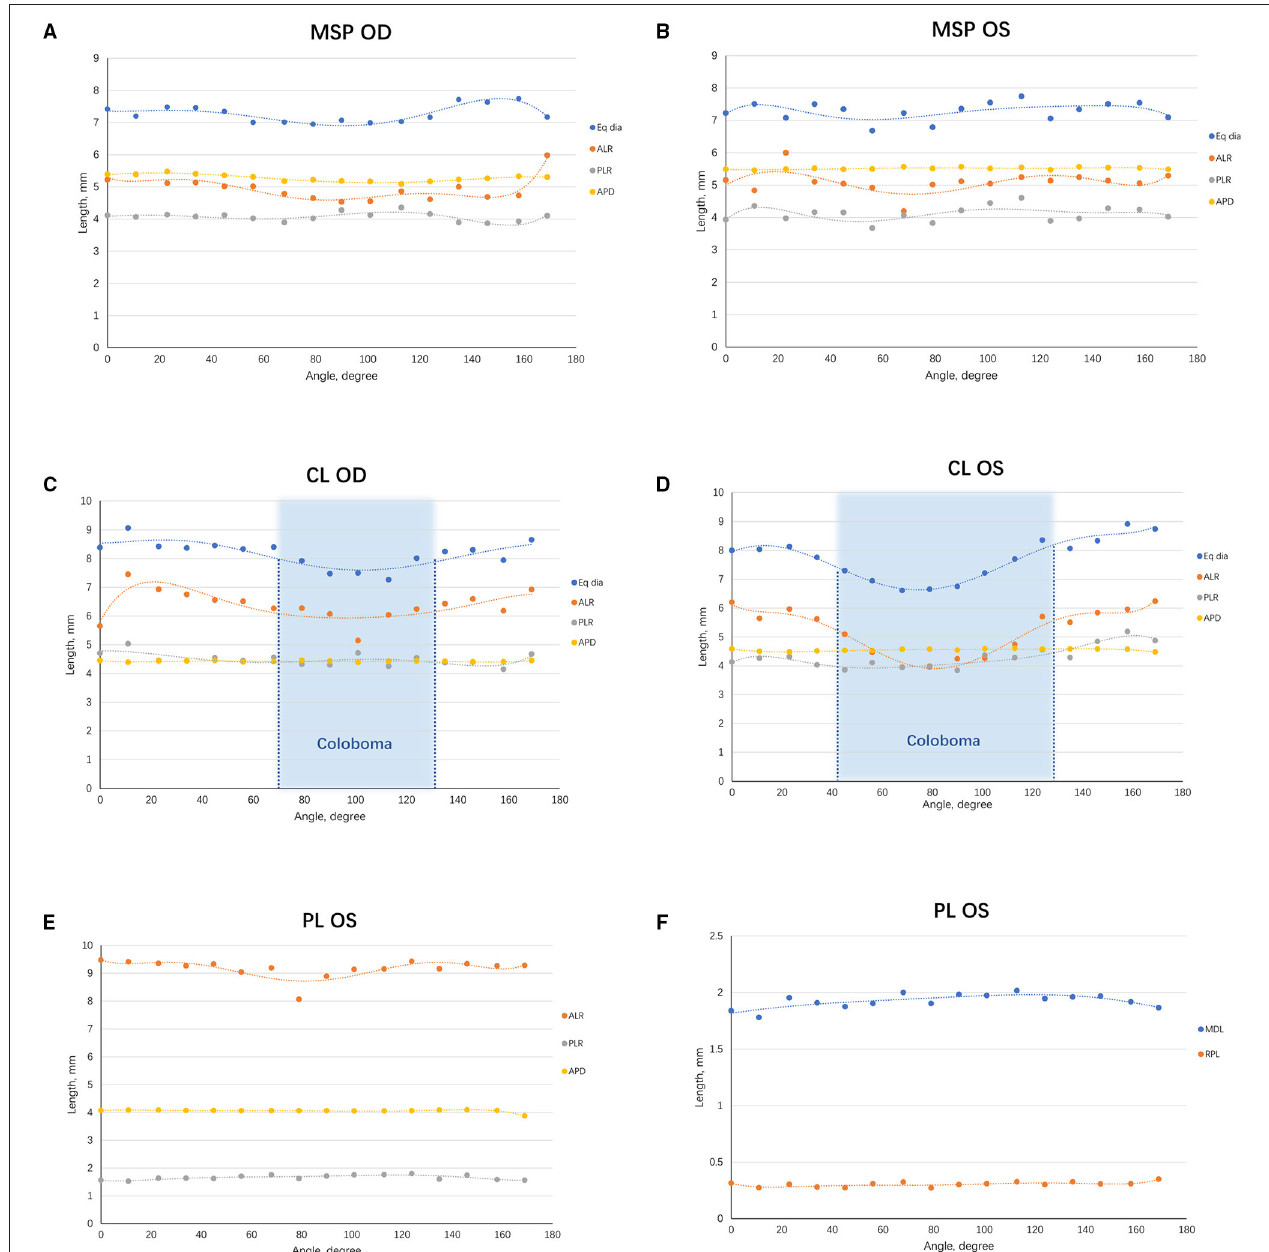
FIGURE 4 | Scatterplots demonstrating the trend of lens biometric parameters from various angles. (A) The lens biometric parameters of the right eye of MSP at different angles were plotted and fitted in curves. (B) A similar graph was made on the left one. (C) The lens biometric parameters of the right eye of CL at different angles were plotted and fitted in curves. The coloboma ranged from 250 ◦ to 311 ◦ (indicated in the blue area). (D) A similar graph was made on the left one. A larger range of coloboma was observed in the left eye (222 ◦ to 308 ◦ , indicated in the blue area). (E) The ALR, PLR, and APD of the eye with PL. (F) The MDL and RPL of the eye with PL. ACD, anterior chamber depth; ALR, anterior lens radius; APD, anteroposterior distance; CL, coloboma lentis; Eq Dia, equatorial diameter; MDL, maximum diameter of the lesion; MSP, microspherophakia; PL, posterior lenticonus; RPL, rear projection length; PLR, posterior lens radius.